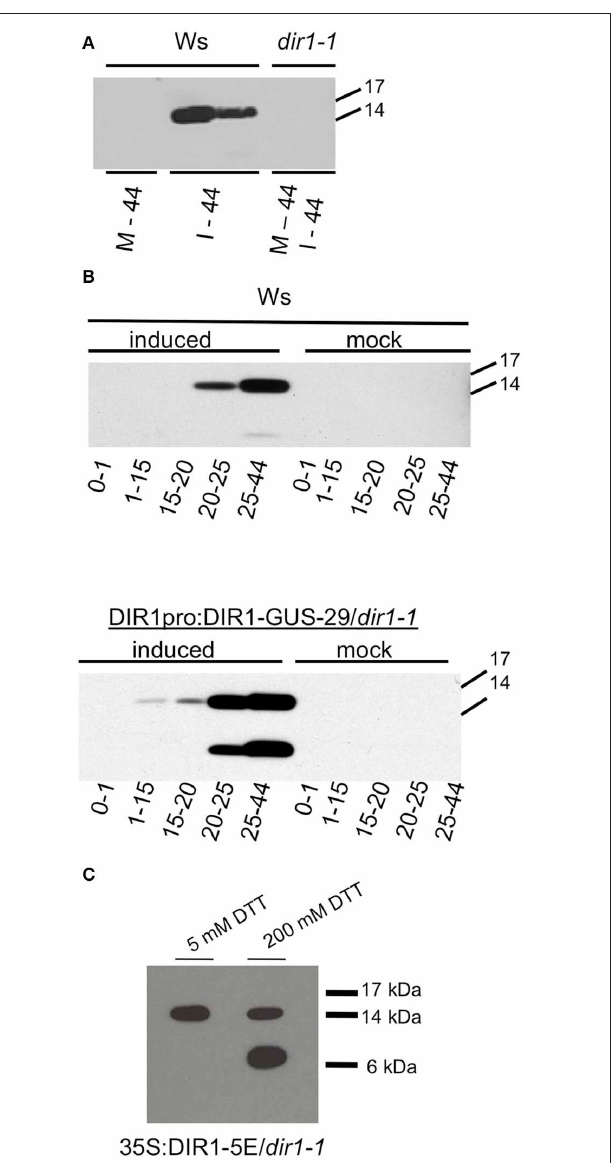
FIGURE 1 | Detection of DIR1 in petiole exudates. (A) Ws and dir1-1 plants were mock-inoculated or inoculated with SAR-inducing Pst (avrRpt2) (10 6 cfu ml − 1 ). Seven petioles per tube were allowed to exude starting at ∼ 8hpi until 44hpi ( = one exudate). Each exudate was lyophilized and subjected to protein gel blot analysis with the DIR1 antibody. M-44 = mock-inoculated petioles exuded for 44hpi, I-44 = petiole from leaves induced for SAR exuded for 44hpi. (B) Ws and DIR1pro:DIR1-GUS-29/ dir1-1 were mock-inoculated or induced for SAR with Pst (avrRpt2) (10 6 cfu ml − 1 ), petiole exudates were collected from ∼ 8hpi for 0–1h, then transferred to another tube for 1–15h, transferred again for 15–20, then for 20–25 and 25–44hpi (denoted by arrows). Exudates were lyophilized and subjected to SDS-PAGE. (C) Exudates collected over 44hpi with SAR-inducing Pst (avrRpt2) (10 6 cfu ml − 1 ) from the DIR1 overexpression line (35S:DIR1-5E/ dir1-1 )were lyophyilized and resuspended in 5 or 200mM dithiothreitol (DTT) and subjected to protein gel blot analysis with the DIR1 antibody. Protein molecular weight markers are indicated (17,14, 6 kDA). (A,B) have been repeated with similar results three times. (C) has been repeated once with similar